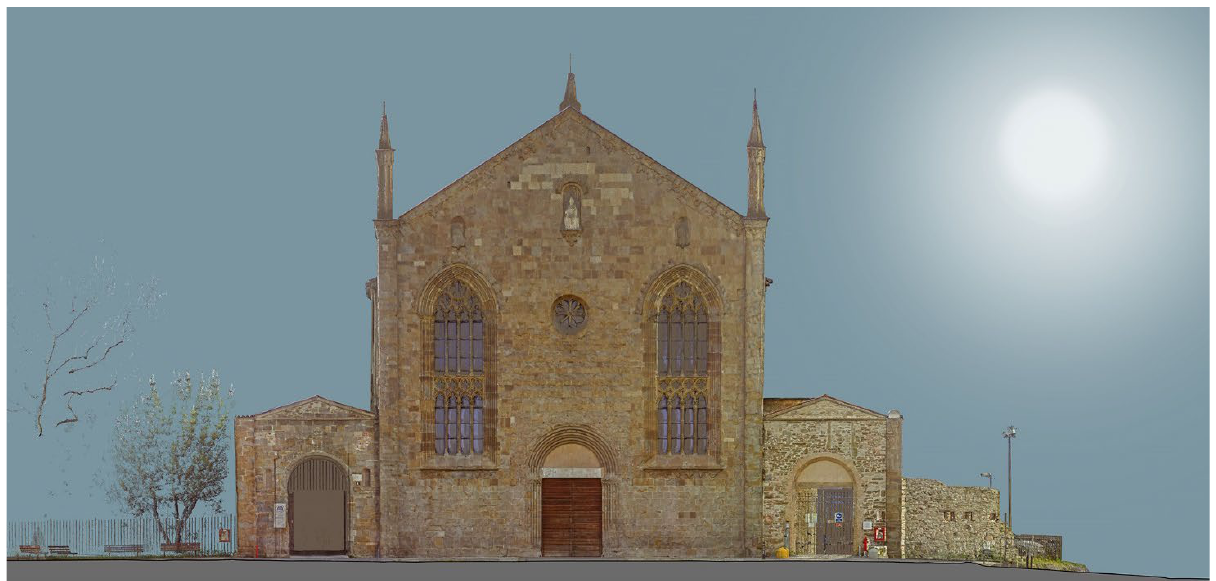
Figure 4. The façade of the church of Sant'Agostino after the restoration: the orthographic projection of the points